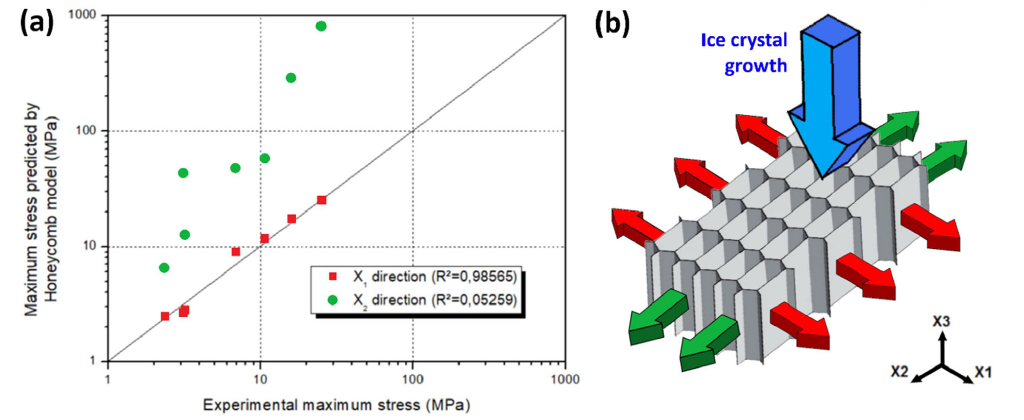
and X directions 1 2